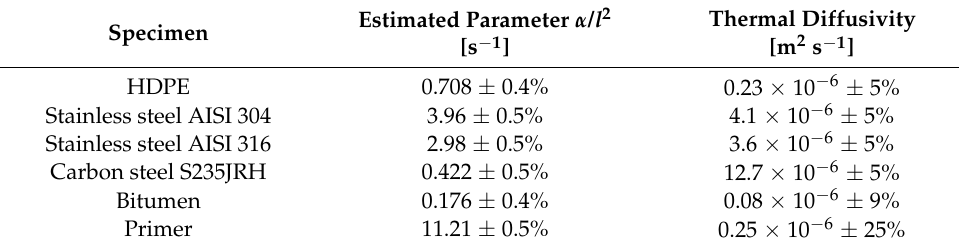
Table 3. Outputs of the LFM measurement of the